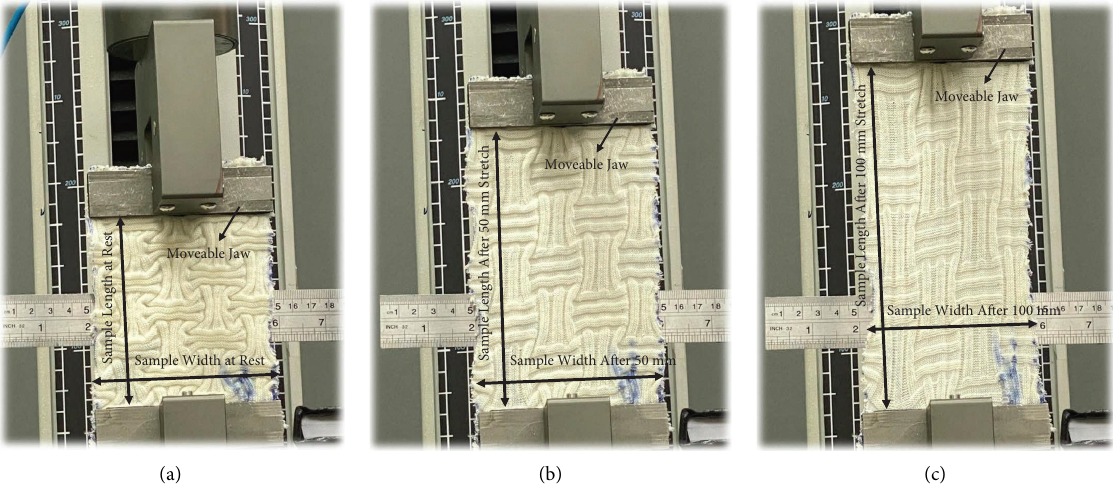
Figure 10: Te behavior of the specimen during the NPR test: (a) sample at rest, (b) sample behavior at 50mm stretch, and (c) sample behavior at 100mm stretch. Table 3: Characterizations with standards and their units. Sr. no.